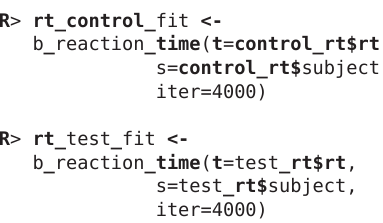
plot_means provides an alternative and visualizes the parameters that define the means of each model ( Figure 9